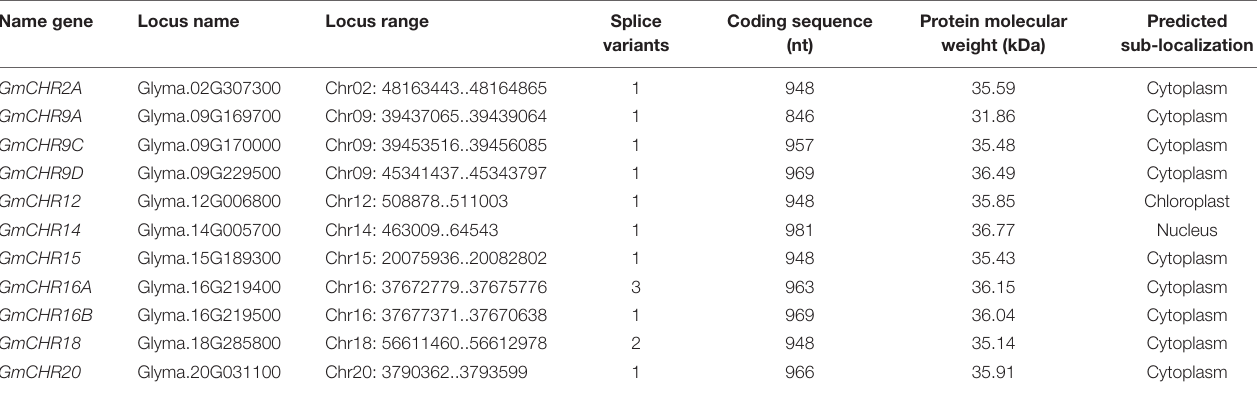
TABLE 1 | Characteristics of soybean chalcone reductase gene